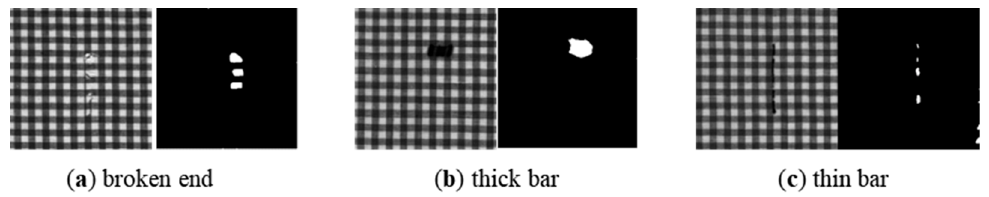
Figure 11. Star-patterned fabric defect of detection results.